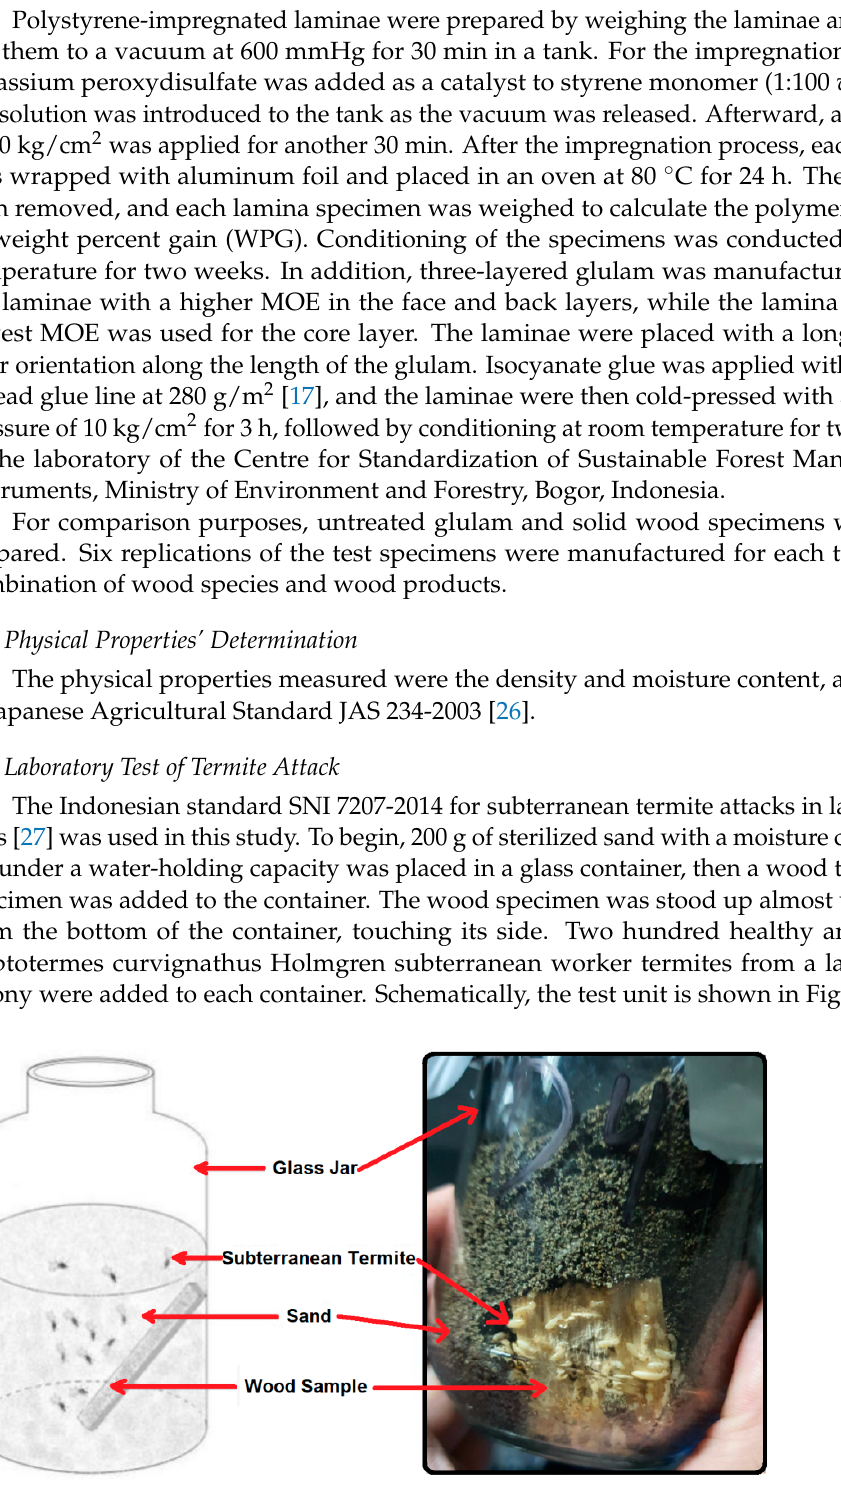
Figure 1. Laminae and glulam manufacturing scheme.